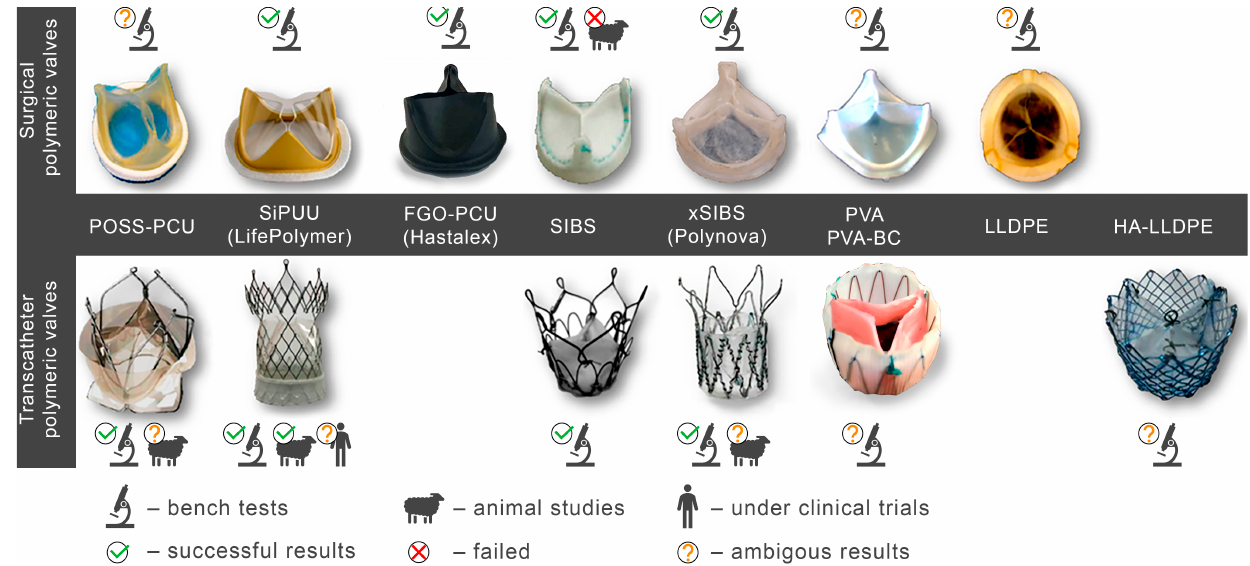
Figure 3. Polymeric valves developed in the last decade for surgical open-heart valve replacement (SVR) and polymeric valves for transcatheter valve replacement (TVR). (SVR) and polymeric valves for transcatheter valve replacement